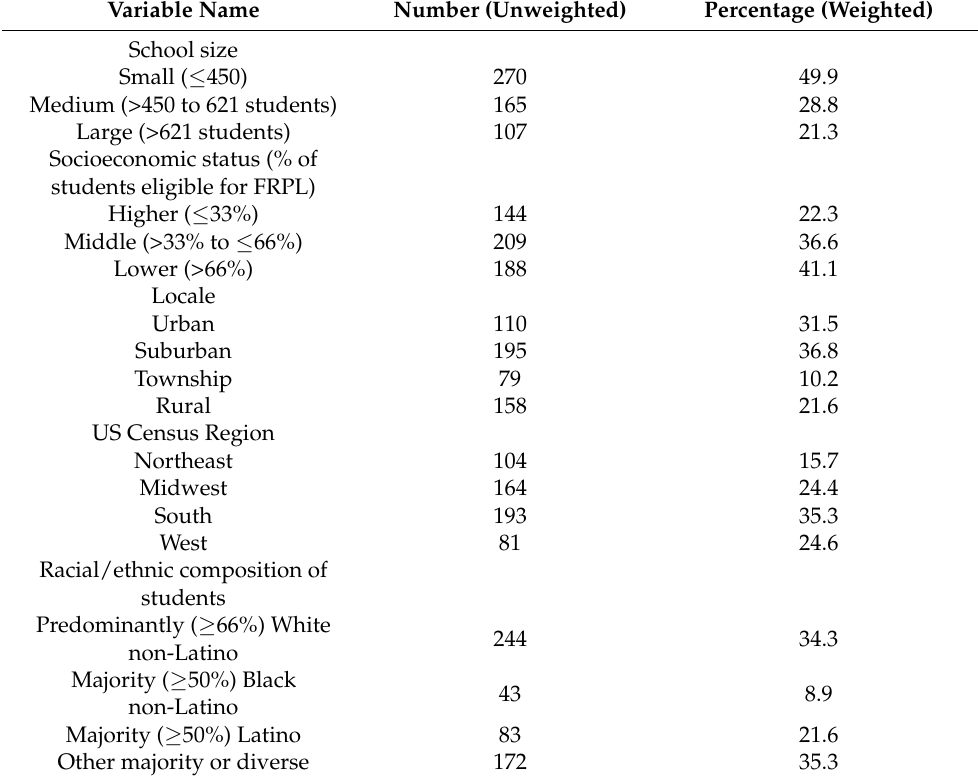
Table 1. Demographic characteristics of 542 US public elementary schools, 2019–20 school